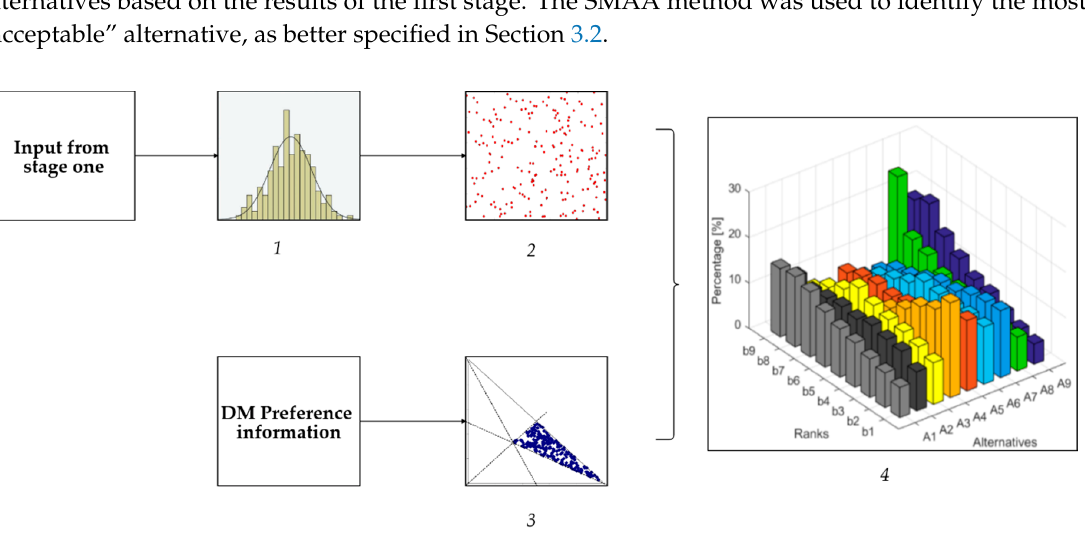
Figure 2. Framework of the proposed methodology (Stage 2): ( 1 ) Definition of the PDF according to mean value and uncertainties; ( 2 ) random sample generation according to correlation matrix; ( 3 ) definition of feasible weight space; and ( 4 ) analysis of the results.